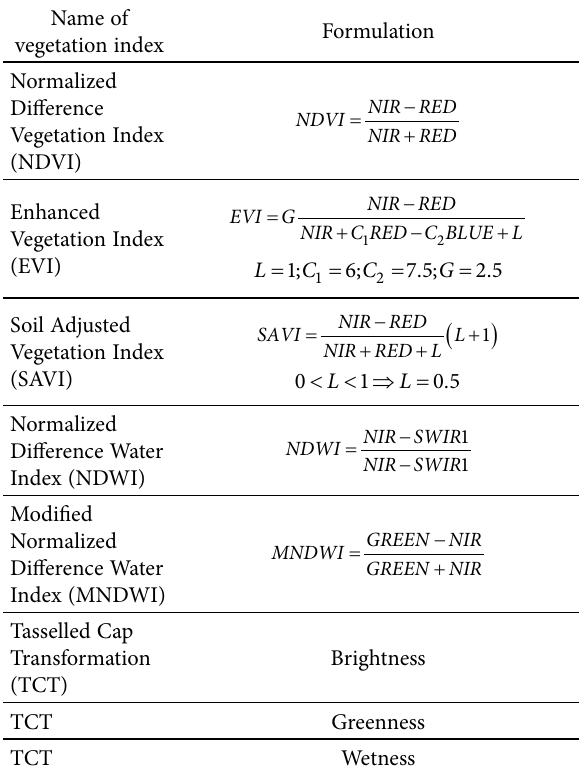
Table 3. Extracted vegetation indices form Landsat 8 imagery Name of vegetation